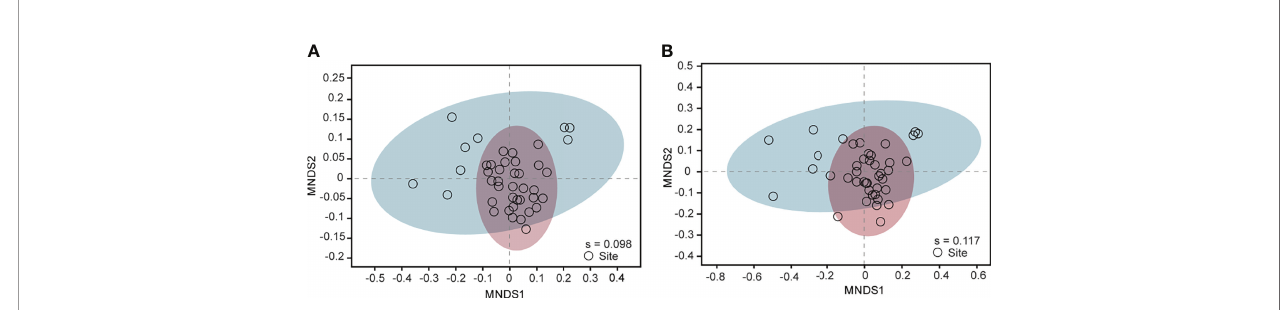
FIGURE 3 | MNDS ordinations represent the dissimilarities according to Bray-Curtis distance among samples based on bacterial community compositions at the phylum (A) and the genus level (B) . Ellipse with different colors suggest individual communities (95% con fi dence interval). s, stress.